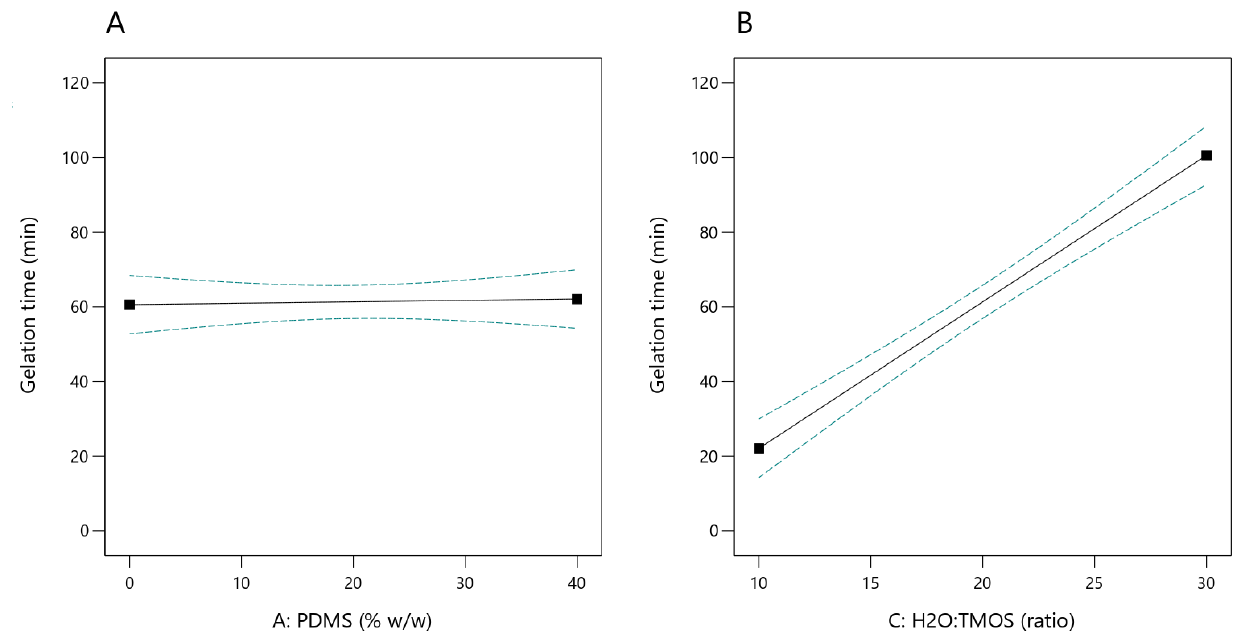
Figure 2. Effect of PDMS content ( A ) and H 2 O:TMOS molar ratio ( B ) on the sol gelation time (the dashed lines indicate the 95% confidence interval).